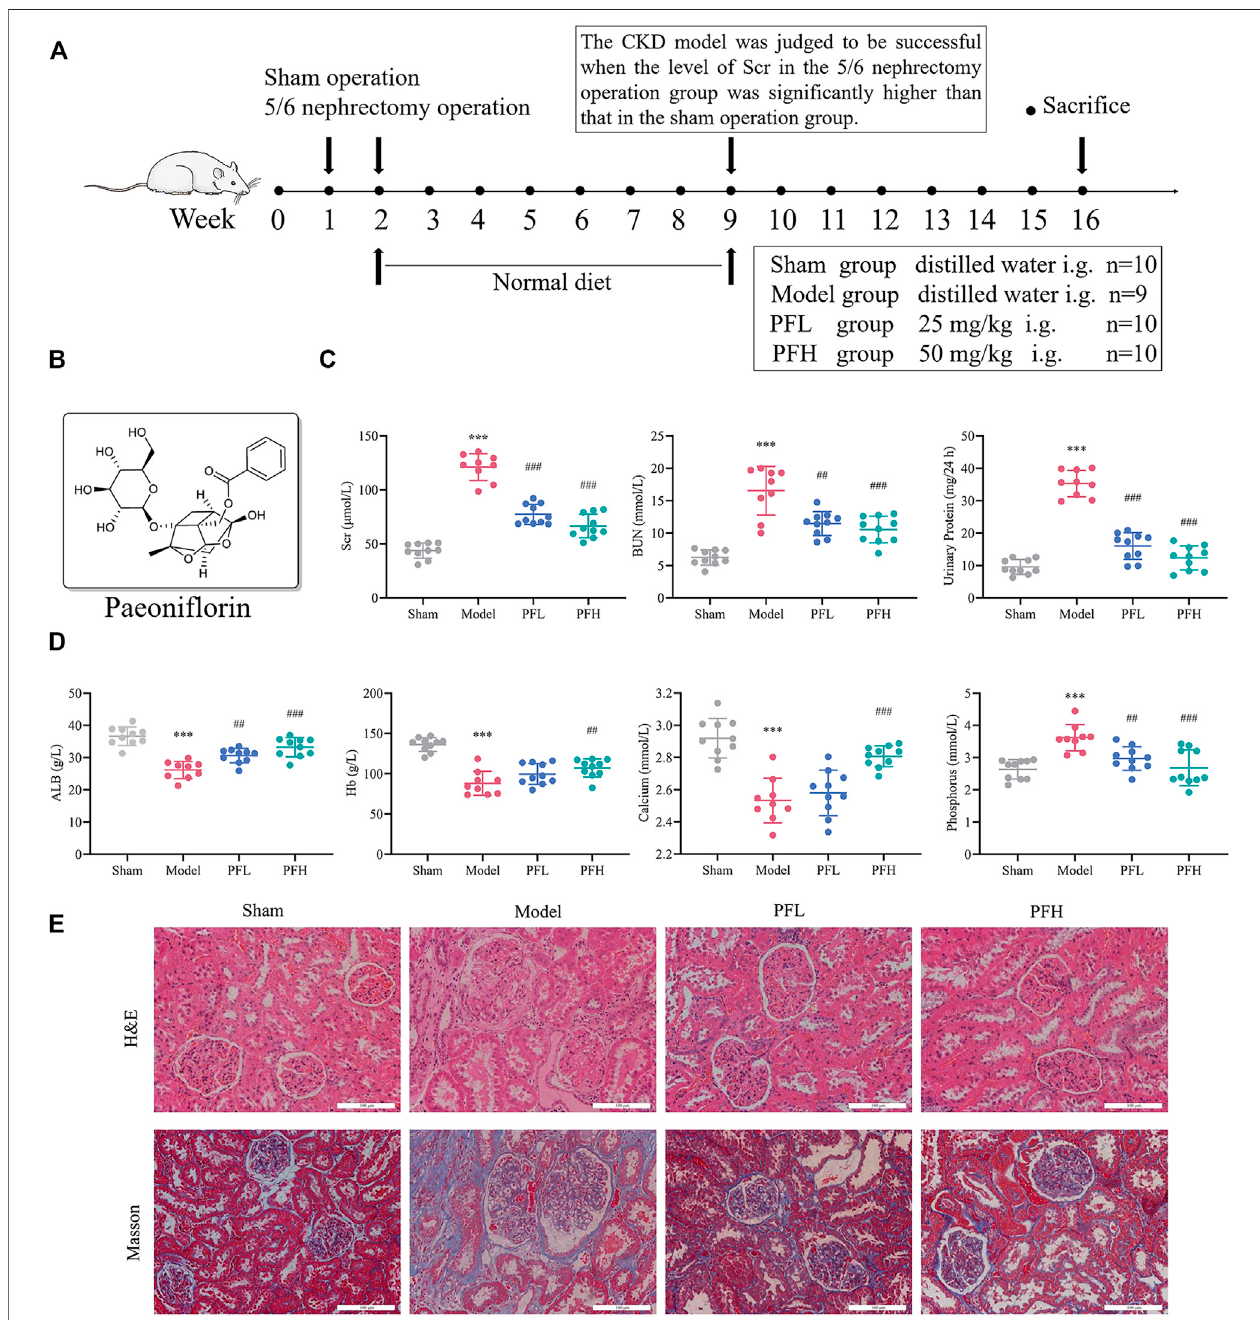
FIGURE 1 | Paeoni fl orin improved renal function, calcium/phosphorus disorders and nutrition index in CKD model rats. (A) Study design of the animal experiment and treatment. (B) Molecular structure of paeoni fl orin (PF). (C) The levels of renal function indexes, including Scr, BUN and 24-h urinary protein. (D) The levels of serum calcium/phosphorus and nutrition indexes (Hb and ALB). (E) Representative images of kidney sections stained with H&E and Masson under the optical microscope (magni fi cation: ×200, scale bars: 100 μ m). The kidneys of CKD model rats showed glomerular sclerosis, focal renal fi brosis, enlargement ofthe tubular lumen, and in fi ltration of in fl ammatory cells. The data are expressed as the means ± standard deviation (S.D). Signi fi cant differences are indicated as * p < 0.05, ** p < 0.01, *** p < 0.001 vs. the Sham group. # p < 0.05, ## p < 0.01, ### p < 0.001 vs. the Model group. PFL, CKD model rats treated with a lower dose (25 mg/kg) of PF; PFH, CKD model rats treated with a higher dose (50 mg/kg) of